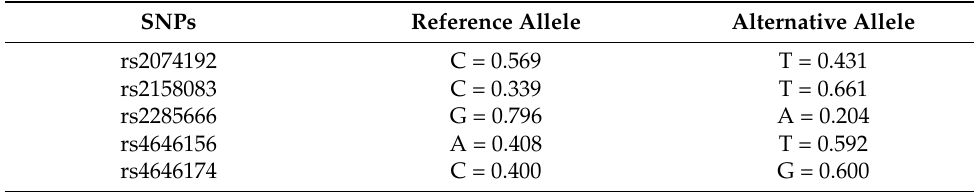
Table 1. Allele frequencies of selected ACE2 gene polymorphisms in the European